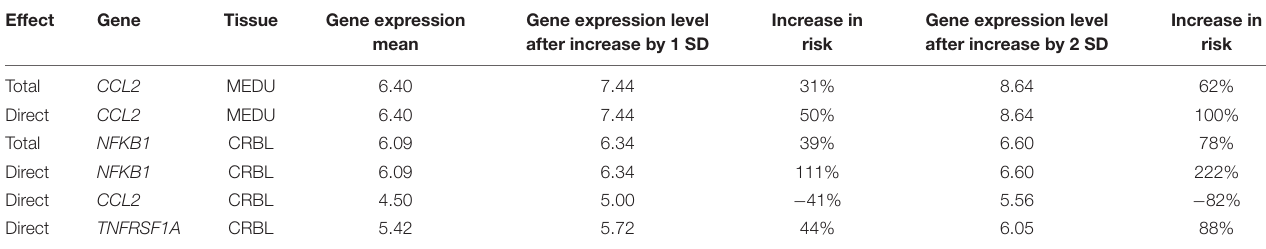
TABLE 5 | Increase in MS risk caused by increase of 1 and 2 SD of gene expression mean. Effect Gene Tissue Gene expression